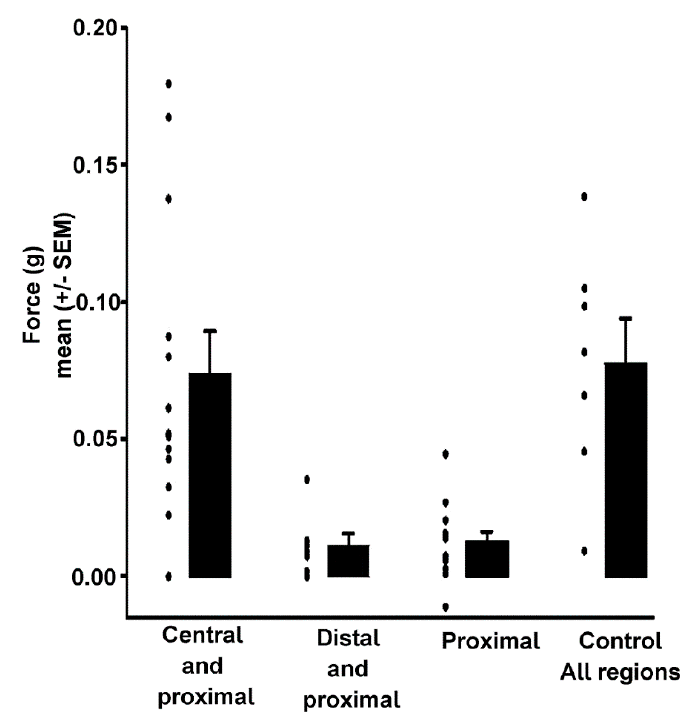
Figure 8. Force development at 40 Hz: The amount of force that can be generated by the central and proximal tissues together is more than the amount the proximal alone can generate. When the central fibers are ablated and similar amount of muscle fibers remain as in the ablated distal preparations, there is a significant decrease in the amount of force that the muscle can generate. There is no significant difference in the control preparations and the ablated distal preparations because the distal do not appear to be responsible for much of the total force generation.